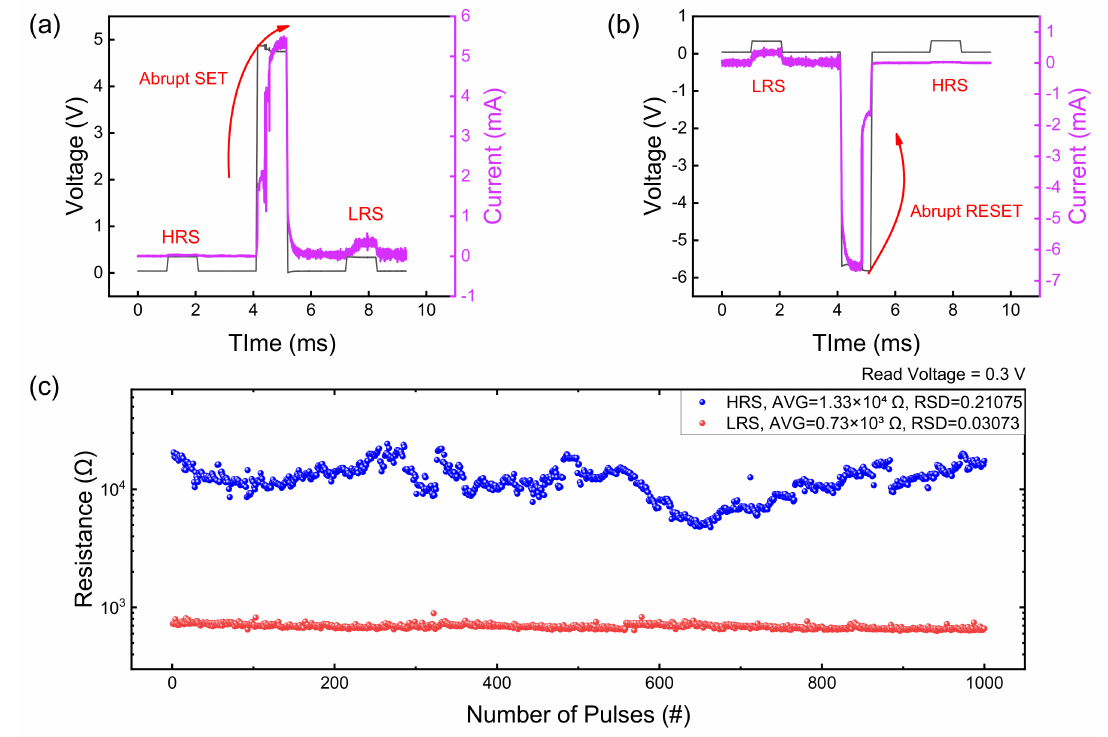
Figure 5. ( a ) Serial pulses to measure current level (0.3 V, 4.8 V, 0.3 V to lead set) and ( b ) (0.3 V, − 5.8 V, 0.3 V to lead reset). ( c ) Resistance of HRS and LRS measured through